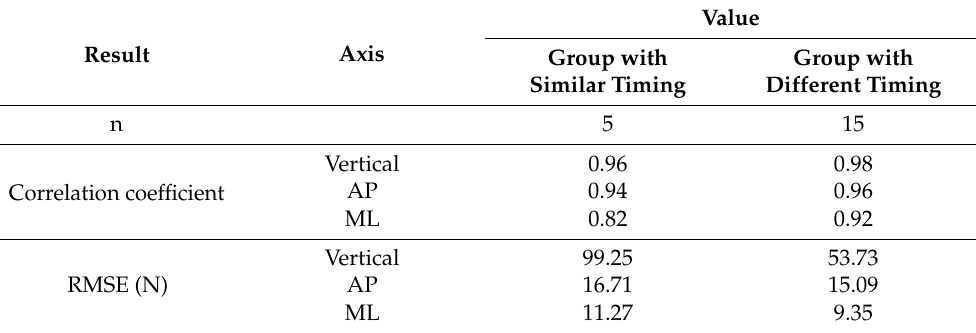
Figure 6. Difference in accuracy between the 1st and 5th metatarsal according to the subject’s gait characteristics. ( a ) The start of pressure on the 5th metatarsal occurred before the start of pressure on the 1st metatarsal. ( b ) The start of pressure on the 5th metatarsal and the start of pressure on the 1st metatarsal occurred at the same time. Table 4. Difference in accuracy according to the timing of the pressure on the 1st and 5th metatarsal. High correlation coefficients and low RMSEs were observed in the group with different timing, which represents a relatively common